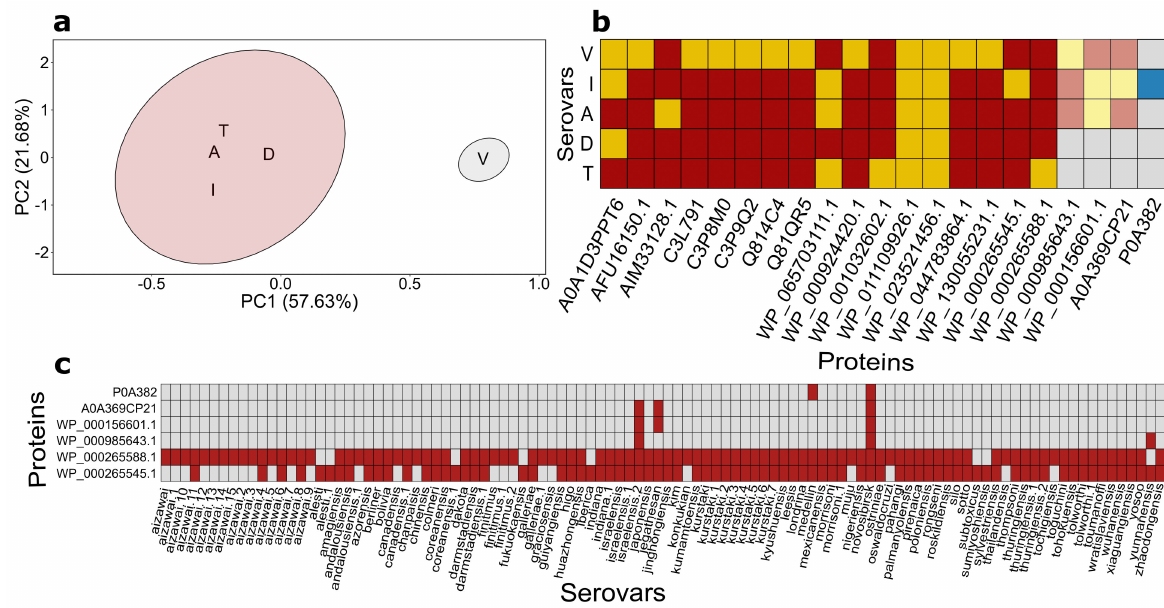
Figure 3. The distribution of genes related to proteins identified during the proteomic assay among analyzed samples and publicly available Bt genomes. ( a ) A k-means algorithm clustering results based on binarized proteomic data. ‘A’ and ‘I’ denote avirulent and virulent spores belonging to israelensis serovar, respectively; ‘T’ and ’D’ stand for thuringiensis and darmstadiensis serovars; ‘V’ signifies vegetative cells of strain 800/3. ( b ) The presence/absence of proteins and the corresponding genes among proteomes and genome assemblies with regard to their serovar’s attribution. Red color denotes a gene’s presence in a genome. Blue color indicates the presence of a protein in a proteome; yellow color is used if the protein/gene was found both in the proteome and genome belonging to identical serovars. Red and yellow colors’ intensity is proportional to the number of genomes in which it was detected. ( c ) The presence/absence of genes encoding proteomically-derived proteins among 104 Bt assemblies (15 core genes are not